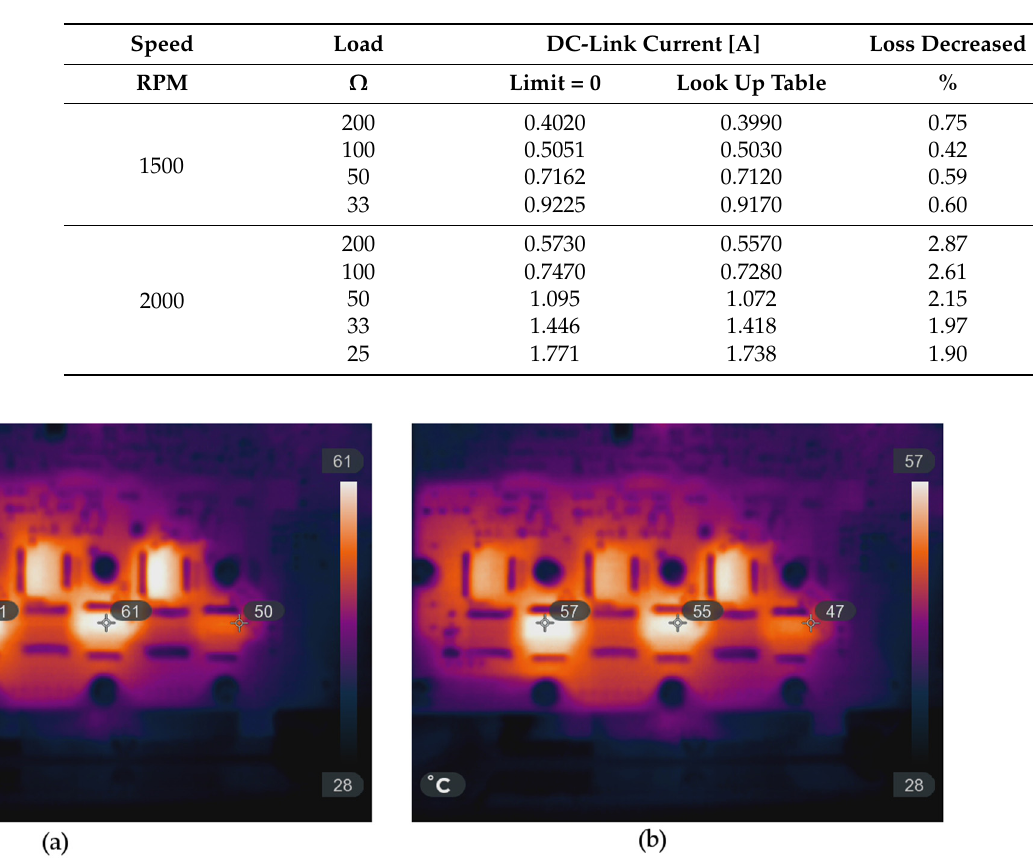
Figure 13. Third-order polynomial function fitted to the measured data (limiting duty-cycle d limit as a function of the inverter output power P in per-units). Table 2. DC-link current measurement.